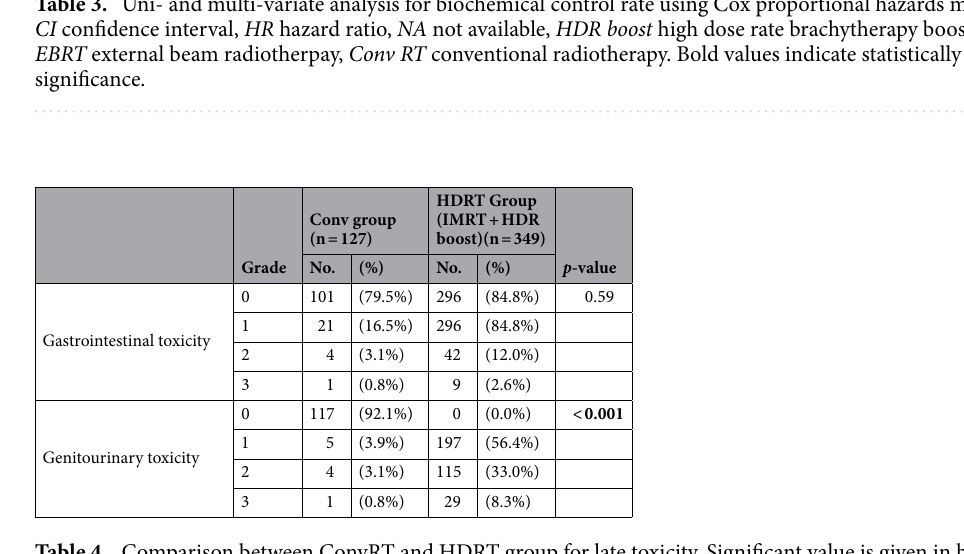
Table 4. Comparison between ConvRT and HDRT group for late toxicity. Significant value is given in